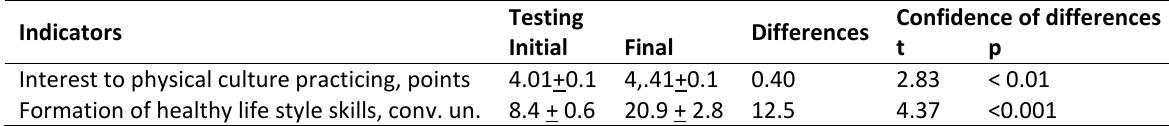
Testing Differences